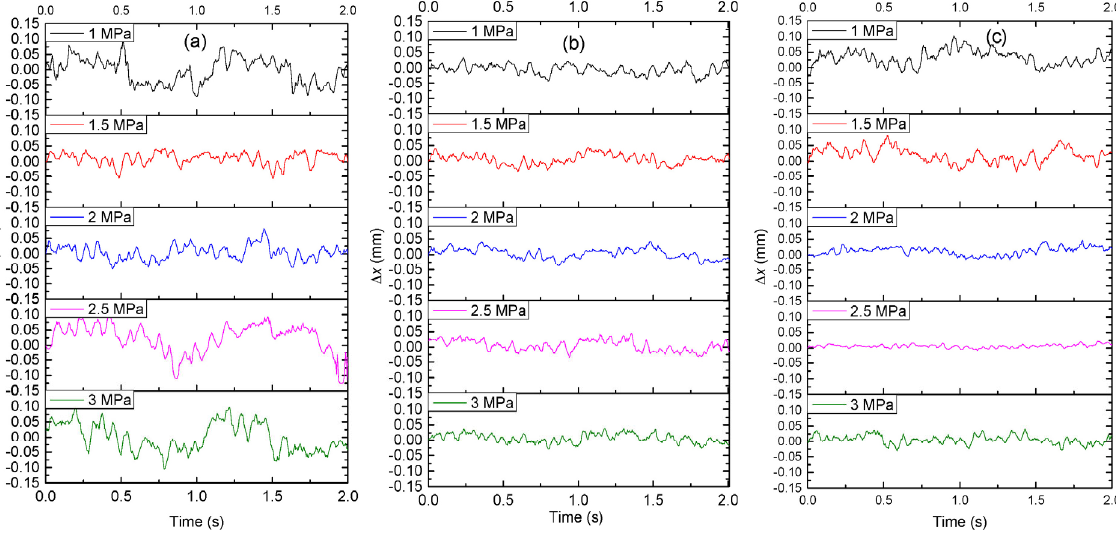
Fig. 10 Δ x of the friction lining in the sliding direction: (a) K25 lining, (b) G30 lining, and (c) GM-3